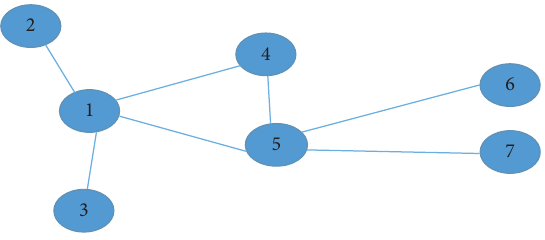
Figure 1: Scenario for uncovered